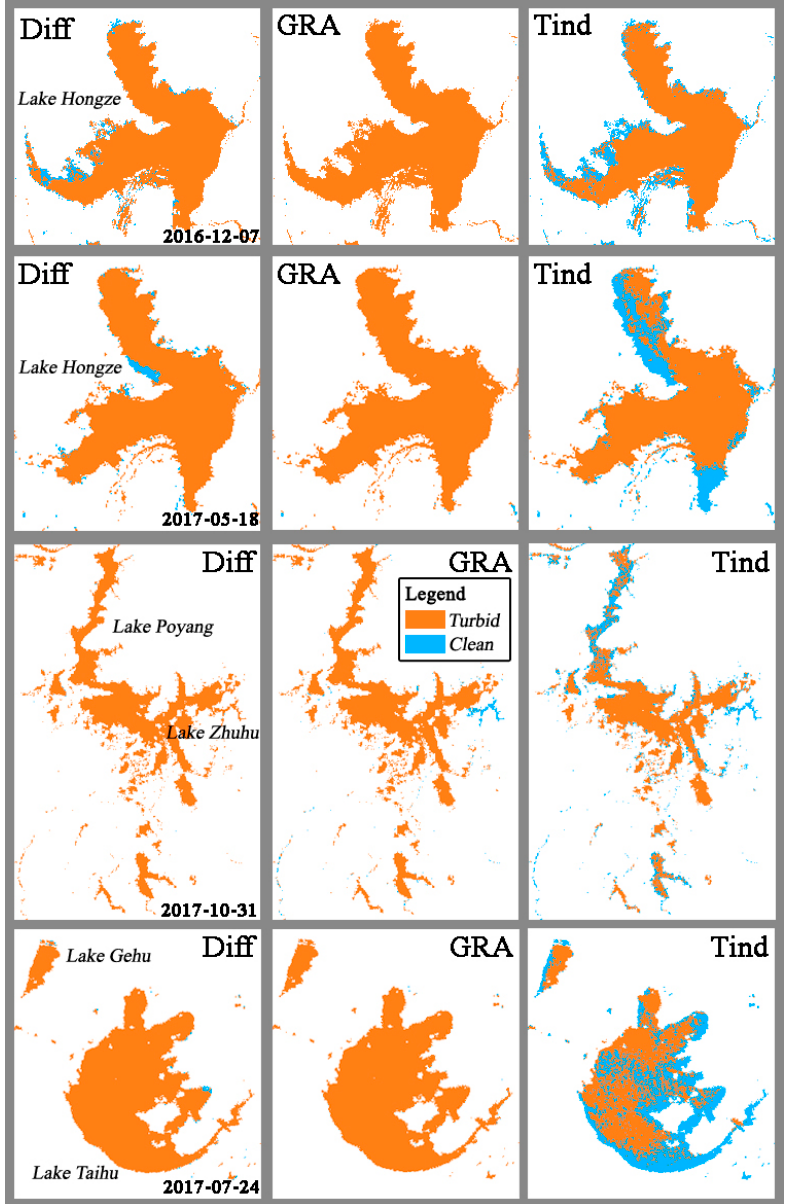
Figure 15. The results of water turbidity classification of Lake Hongze in the winter and the spring, as well as Lake Poyang, Lake Gehu and Lake Taihu. Blue and yellow represent clean and turbid waters, respectively.